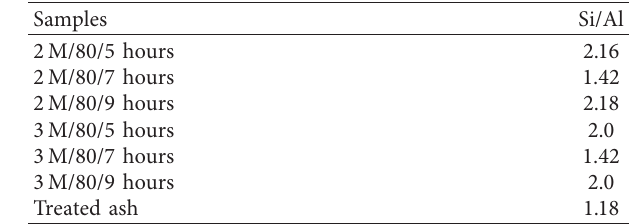
Table 3: Si/Al ratio of Synthesized and Leached